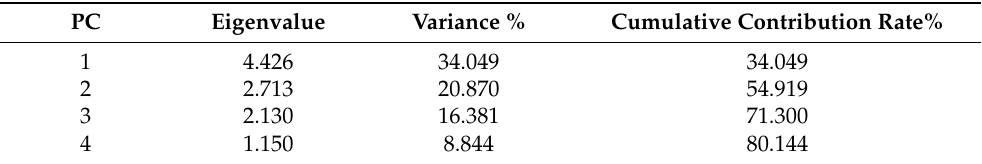
Table 4. Eigenvalue and variance contribution rates obtained from nonlinear principal component